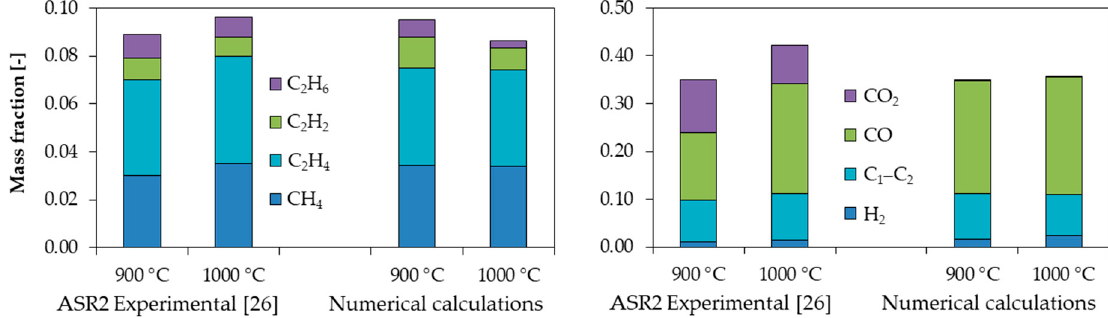
Figure 7. Comparison of the fraction distribution for the ASR 2 raw pyrolysis product—experimental [26] and numerical outcomes.